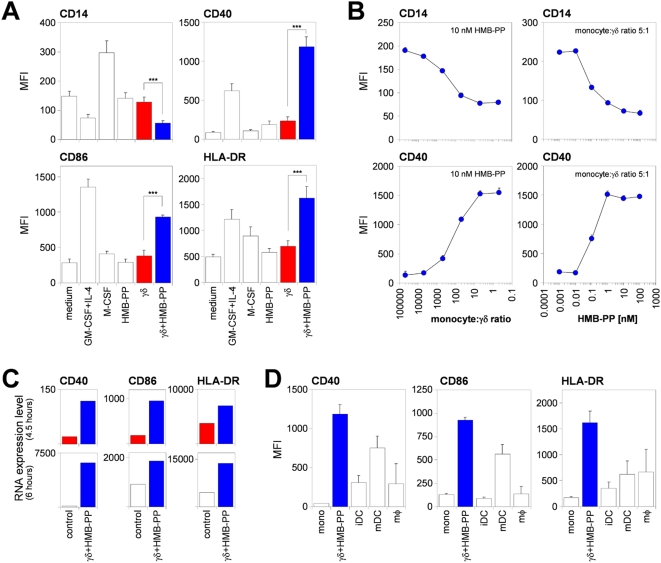
Vγ9/Vδ2 T cell-activated monocytes acquire APC markers.(A) Mean fluorescence intensity (MFI)±SEM of CD14, CD40, CD86, and HLA-DR for monocytes after 18 hours of culture under the conditions indicated (n≥4). (B) MFI±SD of CD14 (top) and CD40 (bottom) for monocytes co-cultured with γδ T cells at various ratios in the presence of 10 nM HMB-PP (left panels), or with γδ T cells at a ratio of 5∶1 in the presence of different concentrations of HMB-PP (right panels), as analyzed after 18 hours in triplicate. (C) Mean mRNA expression levels of CD40, CD86, and HLA-DRα from duplicate measurements for activated monocytes and γδ T cells sorted after 4.5–6 hours from co-cultures in the presence of HMB-PP, compared with control cells sorted from co-cultures in the absence of HMB-PP (top panels), or with freshly isolated, resting monocytes and γδ T cells (bottom panels). (D) MFI±SEM of CD40, CD86, and HLA-DR for freshly isolated monocytes (mono) and monocytes co-cultured with γδ T cells and HMB-PP for 18 hours, in comparison with fully differentiated immature DCs (iDC), LPS-matured DCs (mDC), and macrophages (mφ) (n = 3–6).